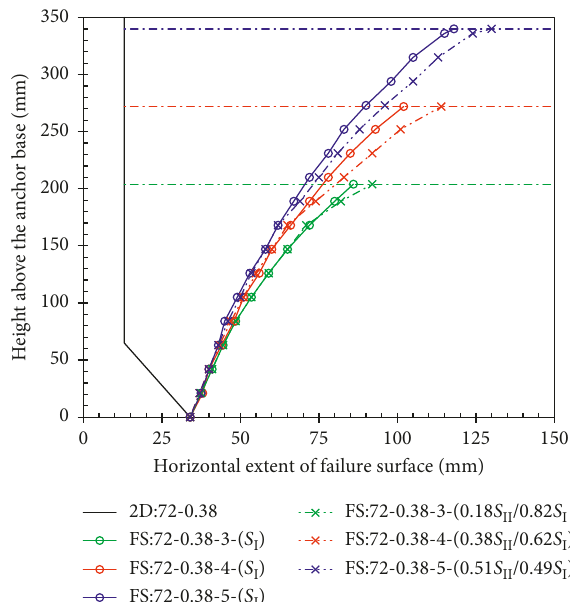
Figure 8: Comparison of FS:72-0.38-3-( S (0.18 S II /0.82 S I ),